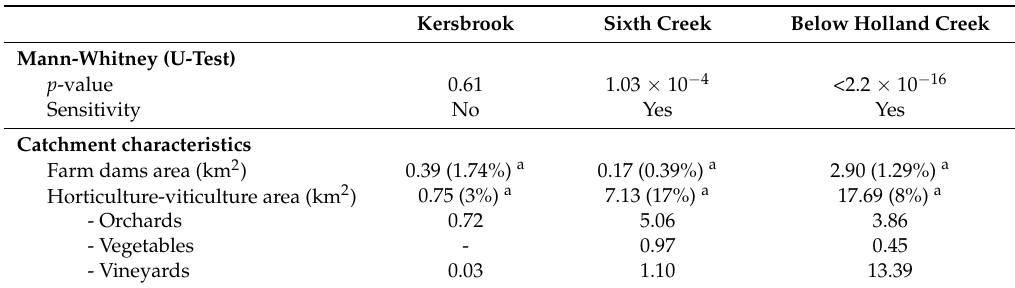
Table 5. Statistical analysis of scenarios for stream flows with and without farm